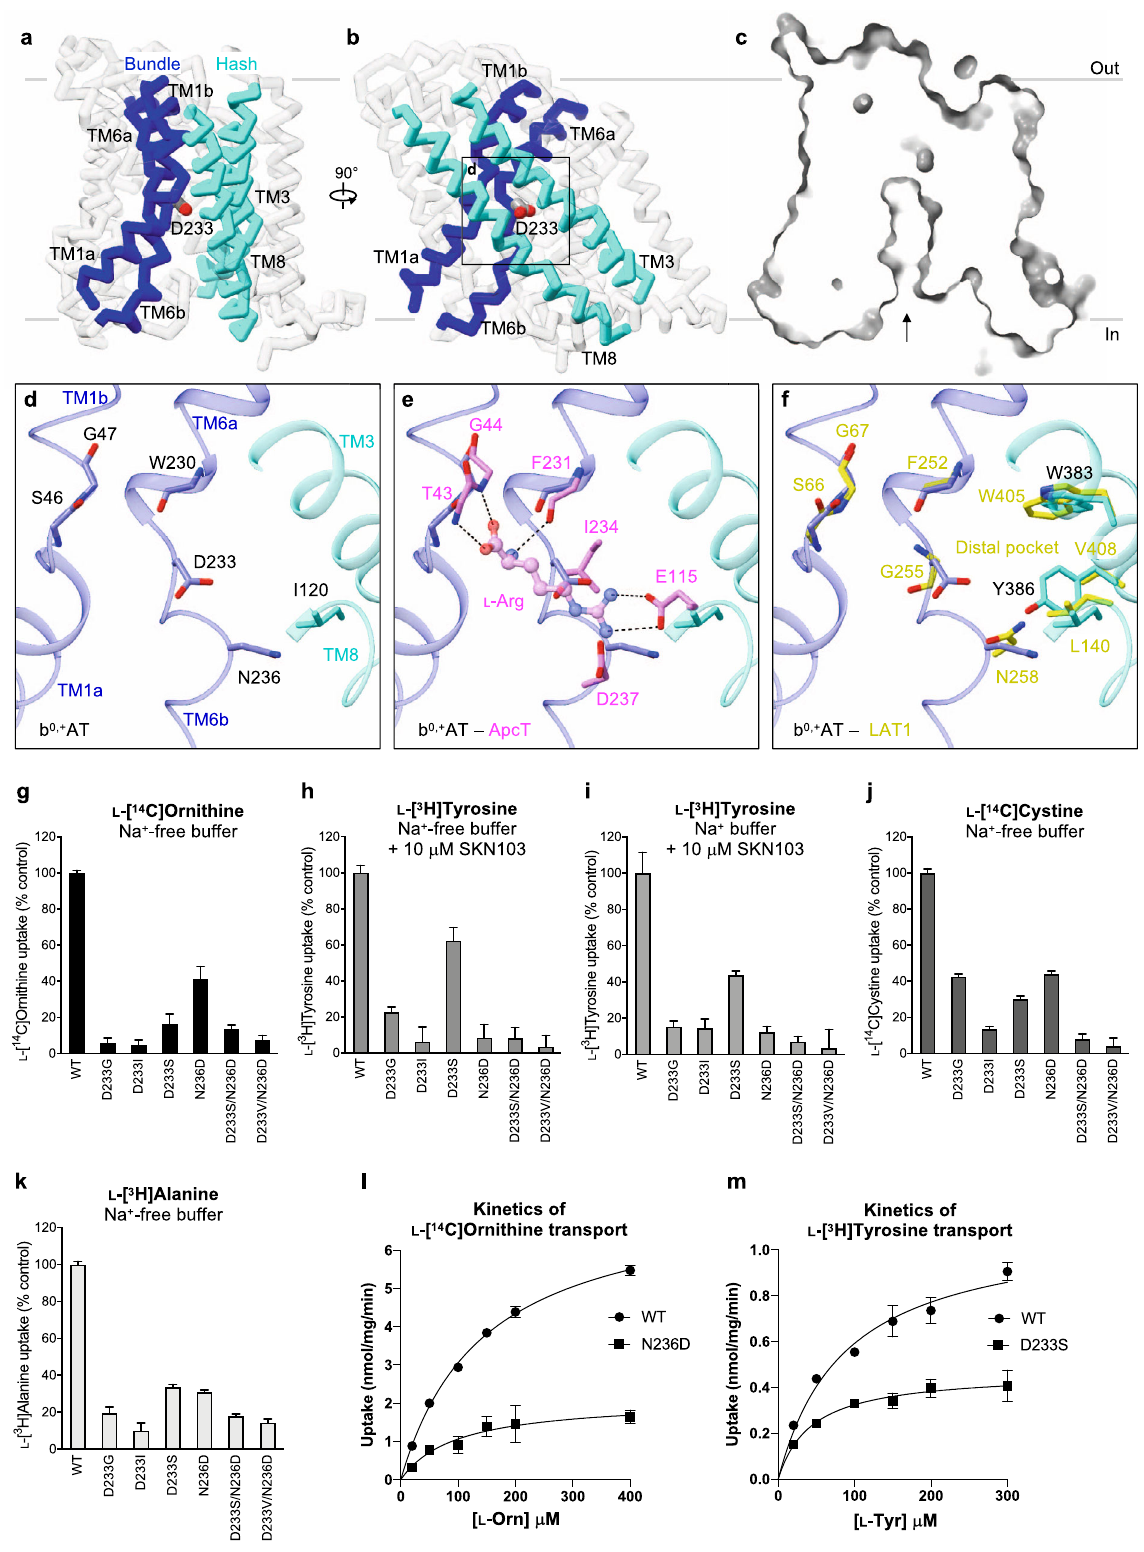
modeled into one of the observed pockets 15 . By contrast, recognition of neutral amino acids did not fully require the negative charge of Asp233, as D233S retained Tyr transport activity (Fig. 9h). The N236D mutation mimics an Asp residue in y + L and CATs (Supplementary Fig. 15b), and it retained Orn recognition to some degree but completely lost Tyr transport (Fig. 9g,